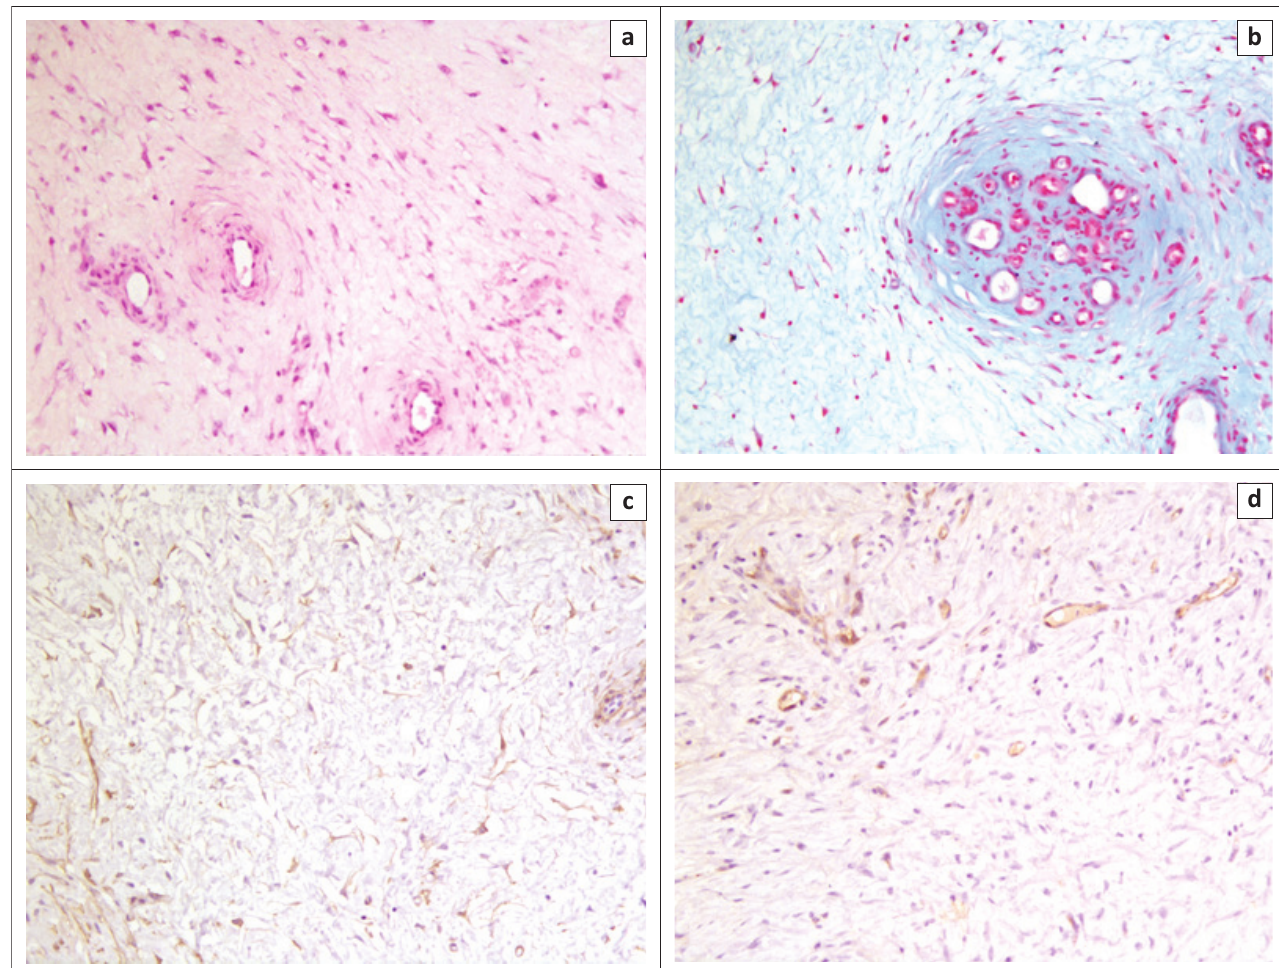
FIGURE 3: (a) Histological features of the mass consisting of a loose neoplastic proliferation of spindle-shaped or stellate cells, immersed in an abundant myxoid matrix with scattered thin-walled blood vessels. H&E, 20×. (b) Abundant myxomatous extracellular matrix positively stained with alcian blue. 20×. (c) Variably intense positivity of neoplastic cells for α-SMA. IHC, 20×. (d) Several von Willebrand factor-positive blood vessels admixed with neoplastic cells. IHC,